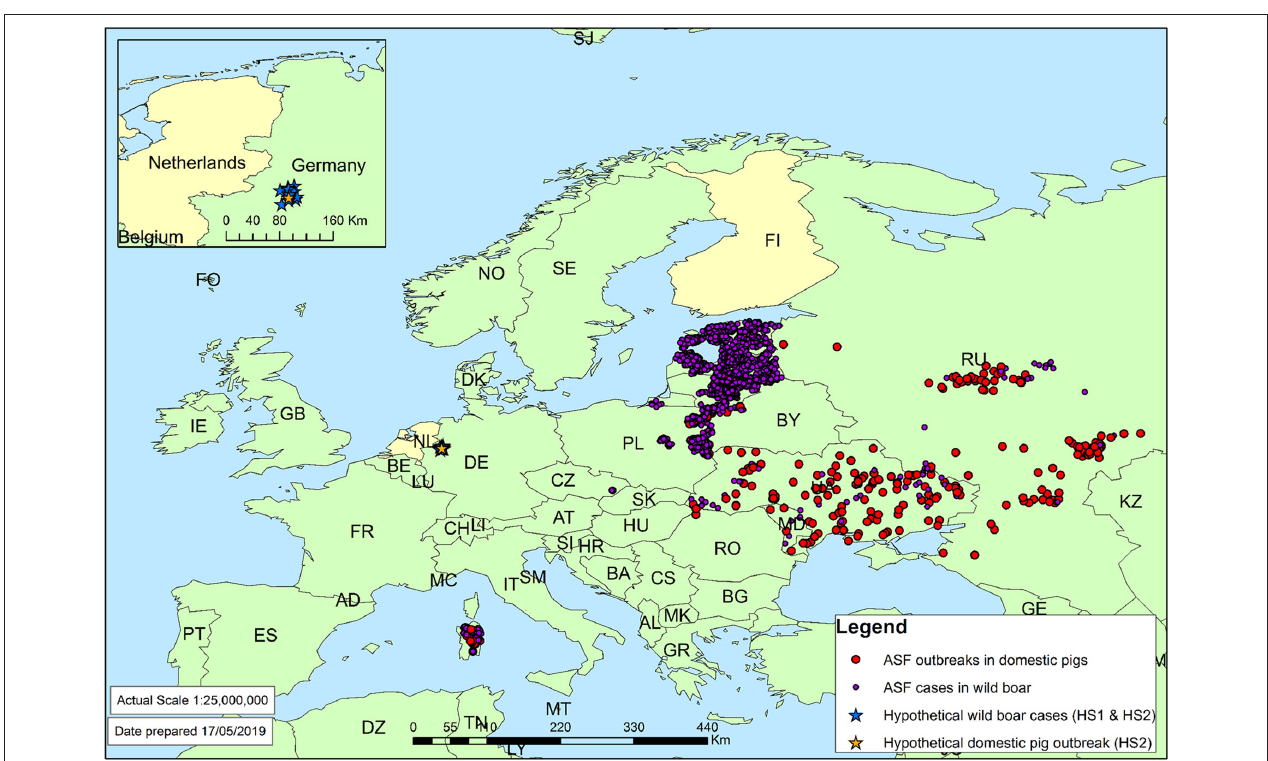
FIGURE 2 | ASF cases in domestic pigs and wild boar in 2017 as reported to the OIE (2). Target countries of the case study (the Netherlands and Finland) have been colored yellow. Inset: location of hypothetical ASF cases in